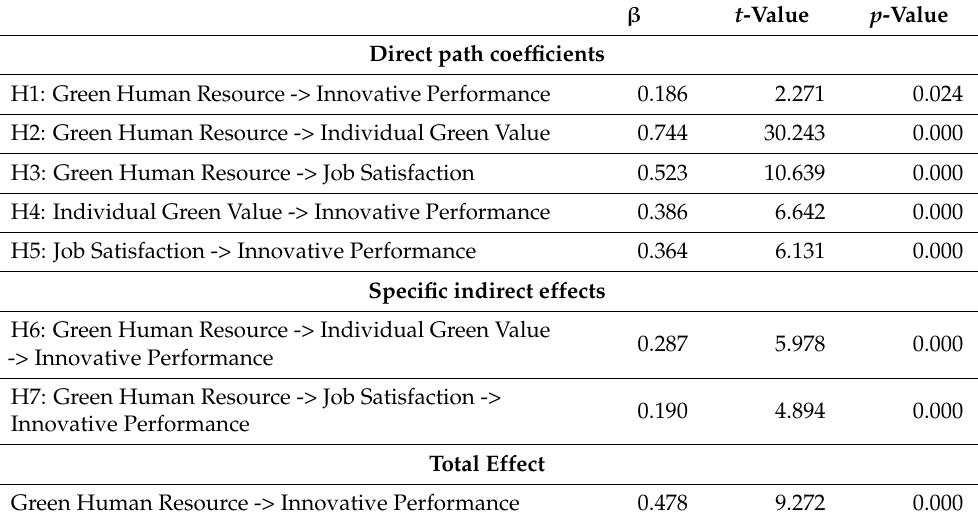
Table 5. Hypotheses